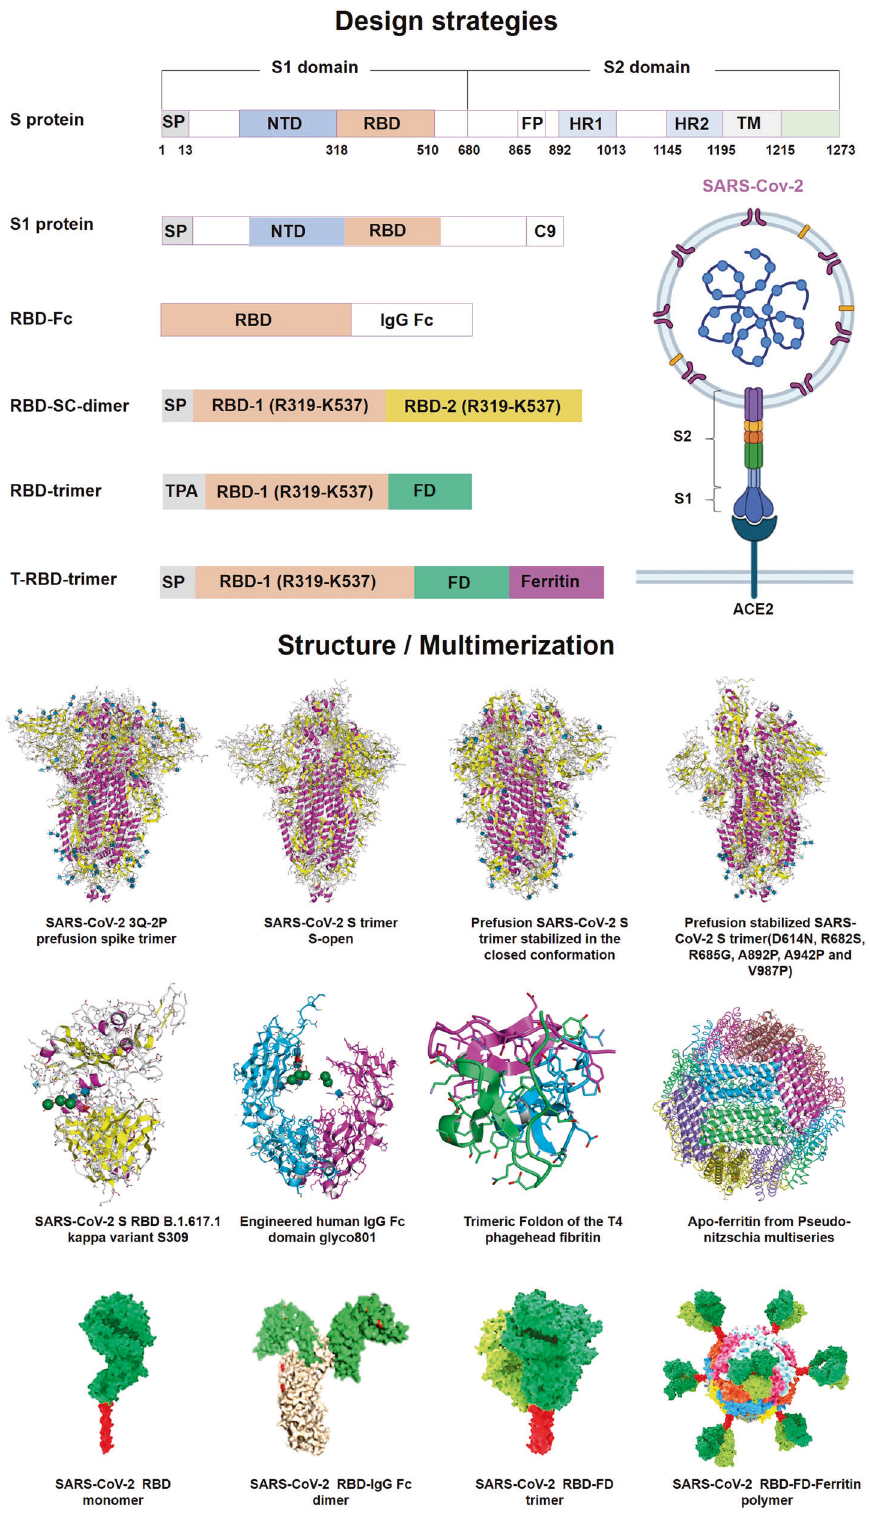
Fig. 9 SARS-CoV-2 mRNA antigen immunogenicity and vaccine design. Full-length S-protein or RBD as a vaccine immunogen has been widely con fi rmed to induce high-af fi nity neutralizing antibodies. SARS-CoV-2 S protein is intrinsically metastable and can be stabilized in a prefusion conformation by structure-based design. 549,550 Prefusion-stabilized SARS-CoV-2 Spike immunogen induces potent humoral and cellular immune responses. 551,552 The RBD peptide is one of the most promising targets to design candidate vaccines. However, RBD has a low molecular weight, which leads to its weak immunogenicity, and can be further improved by forming multimers. Multimerization of RBD protein using humanized IgG Fc, 284 T4 trimerization (FD) 285 or Ferritin 286 have been shown to induce higher neutralizing antibody compared to monomeric antigens, which will provide us with new ideas for designing powerful mRNA vaccines